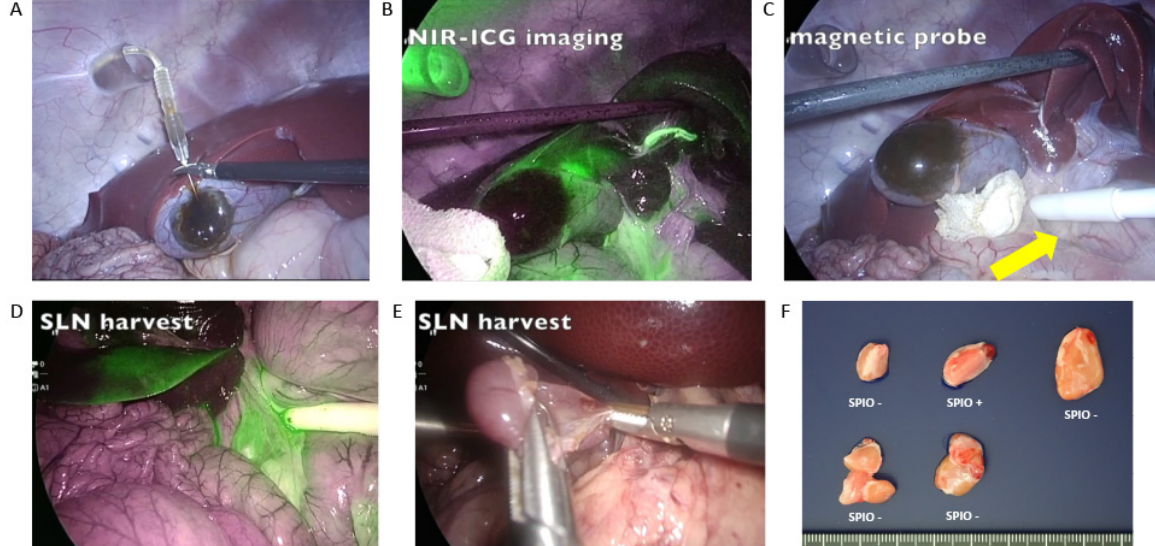
Figure 5. Laparoscopic sentinel lymph node (SLN) detection with a mixed tracer in porcine surgery. ( A ): Injection of the mixed indocyanine green (ICG) dye and magnetic tracer into the gallbladder wall. ( B ): ICG fluorescence signals detected by near-infrared laparoscopy. ( C ): Magnetic field evaluation of lymph nodes with the laparoscopic magnetic probe (yellow arrow). ( D ): Fluorescence signal-oriented identification of SLNs by the magnetic method. ( E ): Resection of the detected SLNs. ( F ): Brown pigmentation with the magnetic tracer in one resected regional lymph node among five. Modified from Mihara et al.